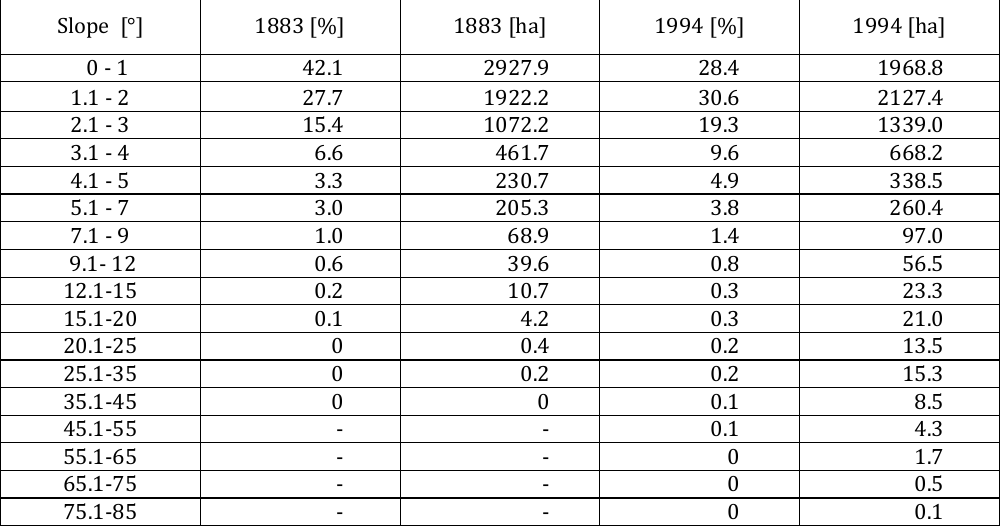
Table 2. Surface percentage of the Bytom area of the determined slope value (the author’s own work) Slope [°] 1883